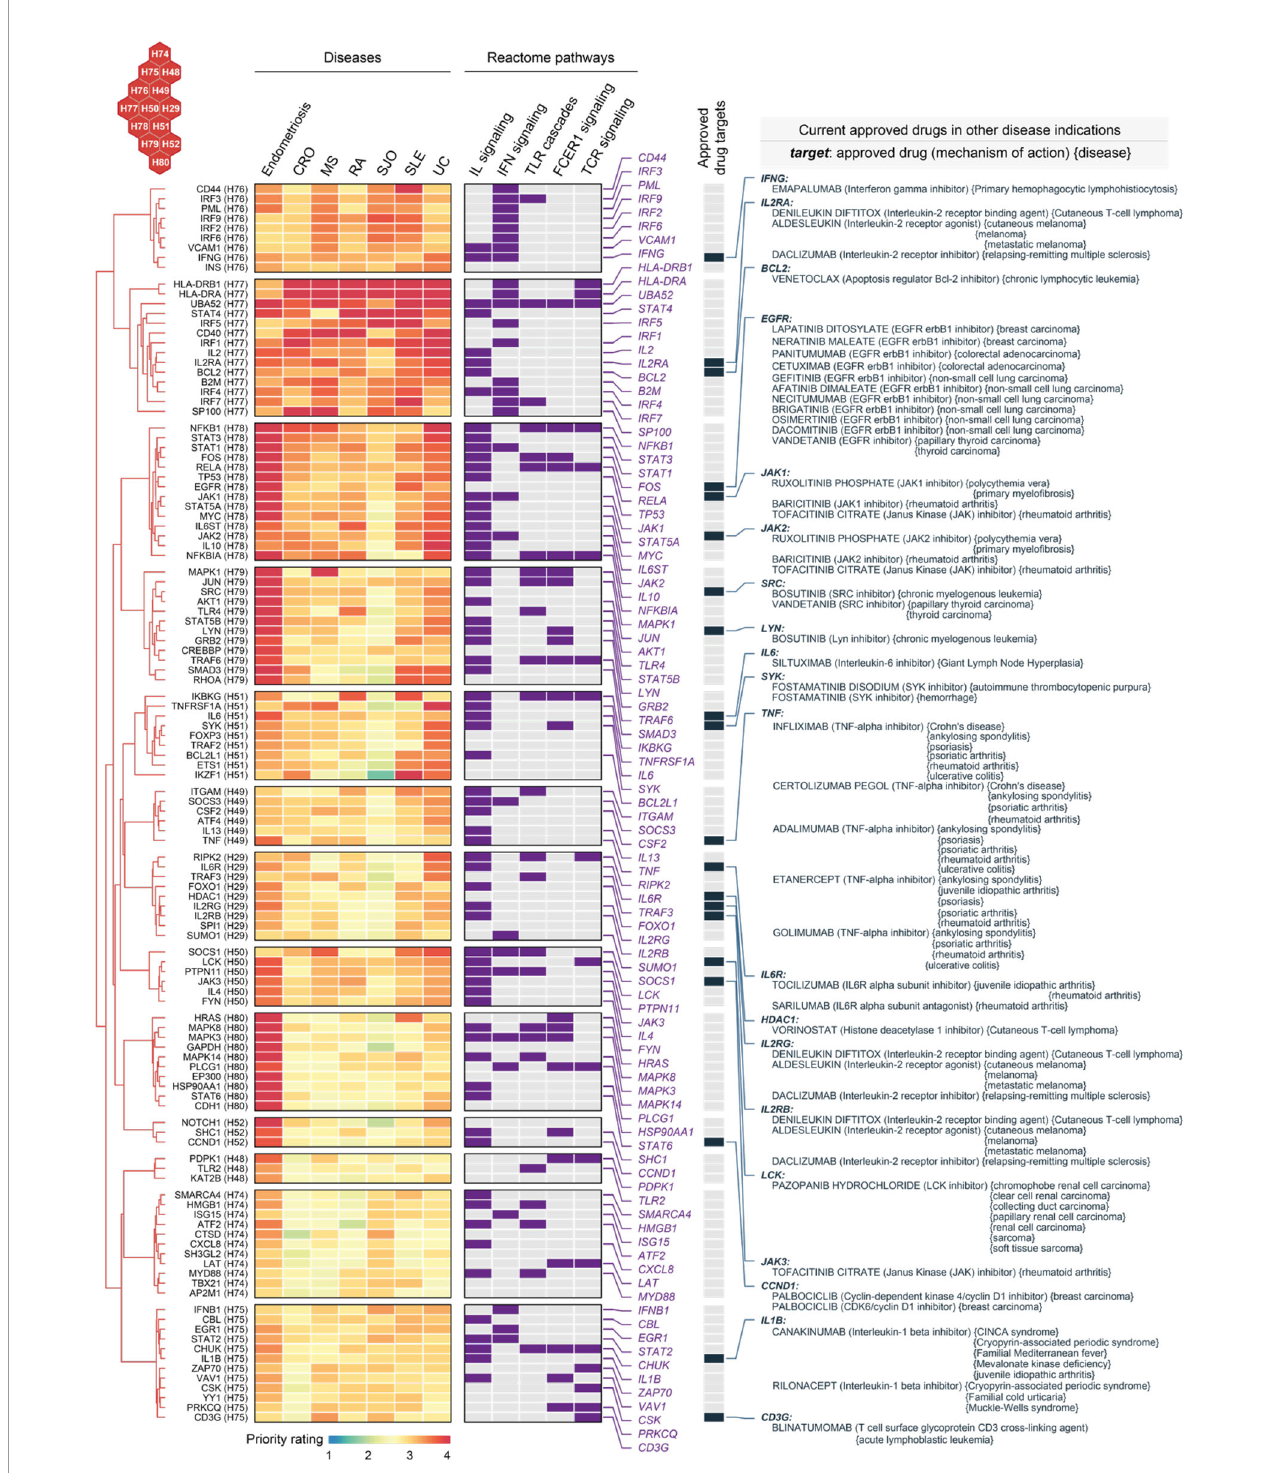
FIGURE 9 | Repurposing evidence for immunomodulatory drugs based on shared target genes in the cluster C6. Heatmap illustrates target genes in C6 prioritized across 7 diseases, with annotations to interleukin (IL), interferon (IFN), toll-like receptor (TLR), Fc epsilon receptor 1 (FCER1), and T-cell receptor (TCR) signalings. Also annotated is the information on approved drug targets, repurposed drugs, mechanisms of action, and disease